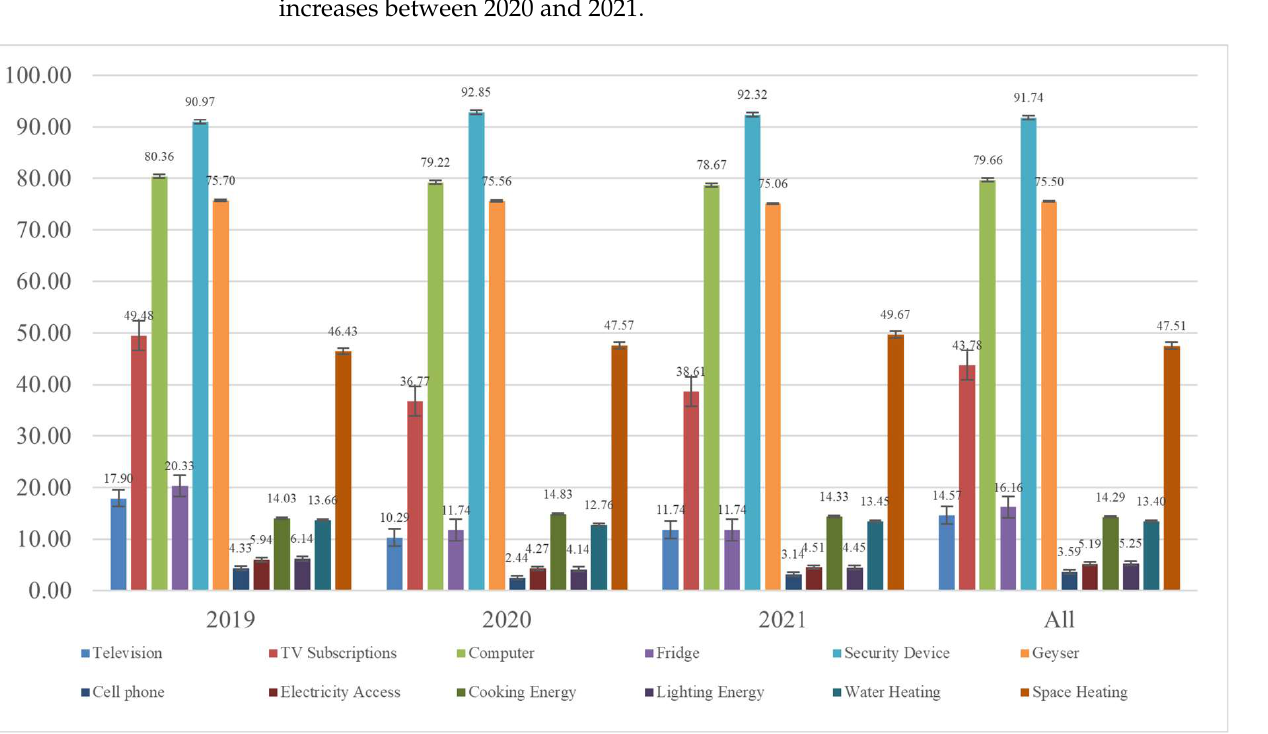
Figure 1. Distribution of deprived households for the selected welfare attributes. Source: GHS datasets (2019–2021).